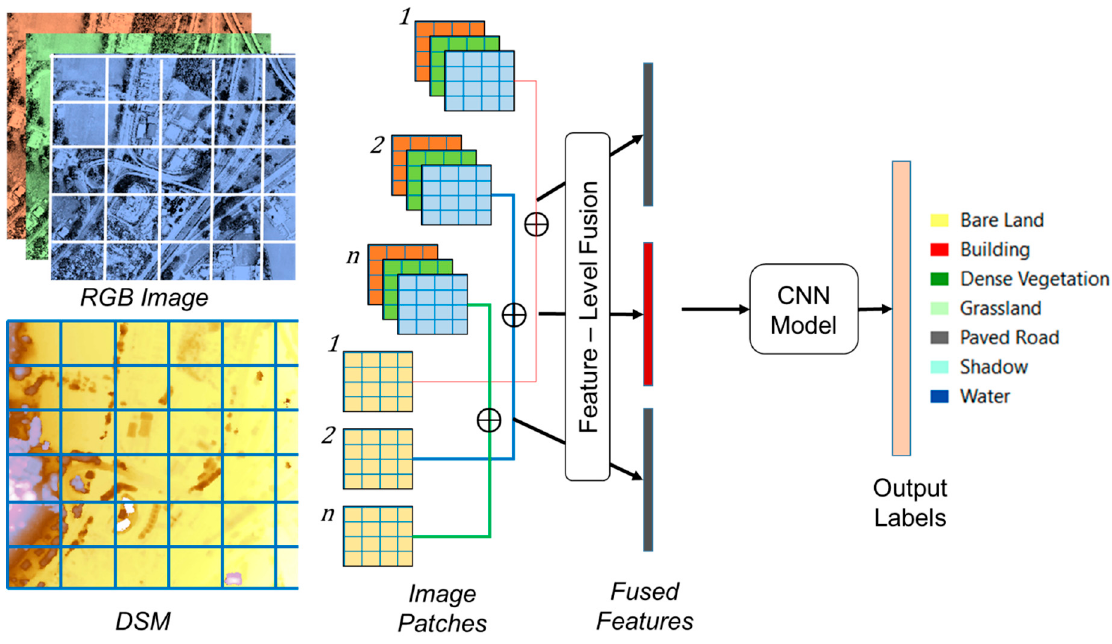
Figure 2. Flowchart of the proposed convolutional neural network (CNN) based classification model.